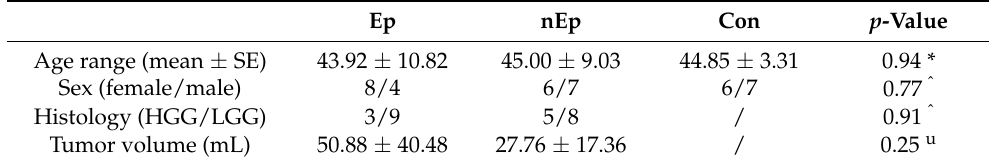
Table 1. Clinical characteristics of patients.